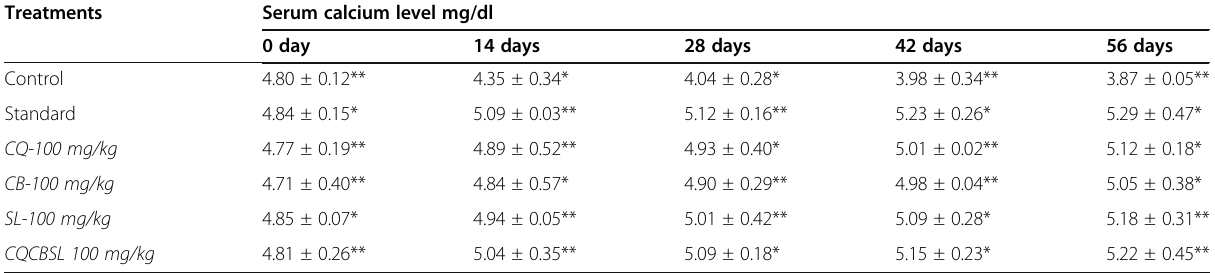
Table 4 The level of serum calcium in the experimental animals after treating with alcoholic extracts of natural compounds